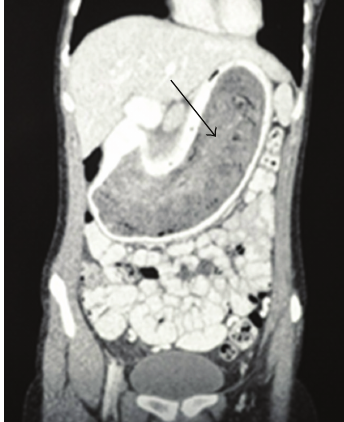
Figure 1: CT scan demonstrating trichobezoar (arrow) occupying the extent of the stomach.